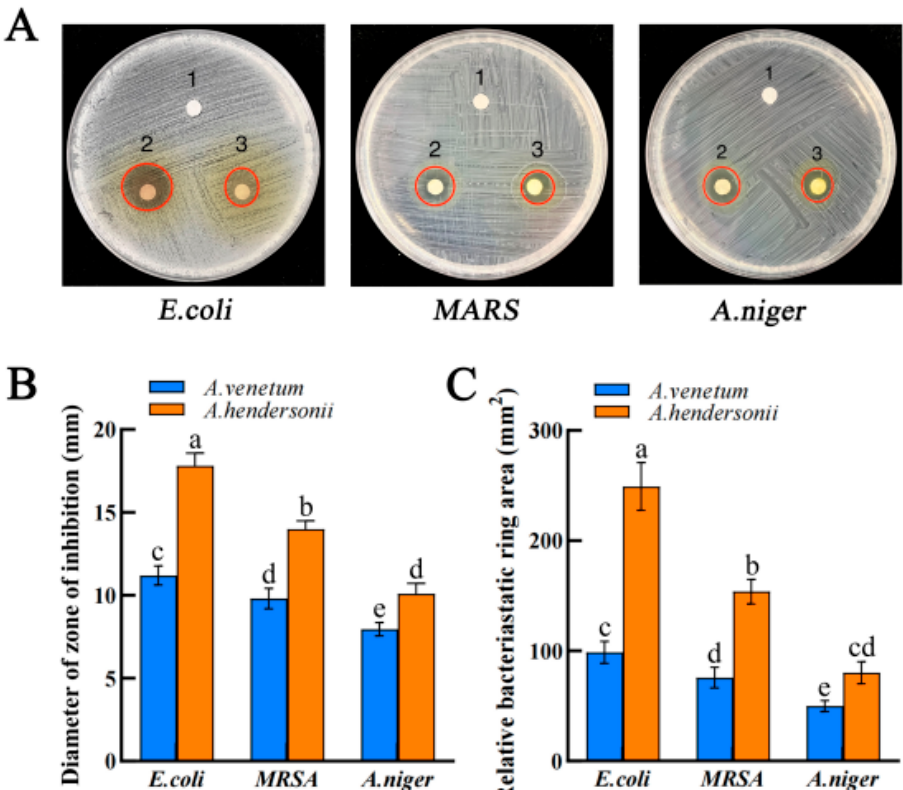
Figure 2. Digital images of inhibition zones of the Apocynum extracts against ( A ) Gram-negative E. coli , gram-positive MRSA , and fungal A. niger after treatment with different treatment groups: (1) Cosolvent; (2) A. hendersonii extract; (3) A. venetum extract, respectively. Diameter of the zone of inhibition. ( B ) The relative bacteriostatic ring area ( C ) was computed using 𝜋𝑟 (cid:2870) . Data are presented as mean ± SD, n = 3. Histogram bars with different letters (a–e) are statistically different ( p <